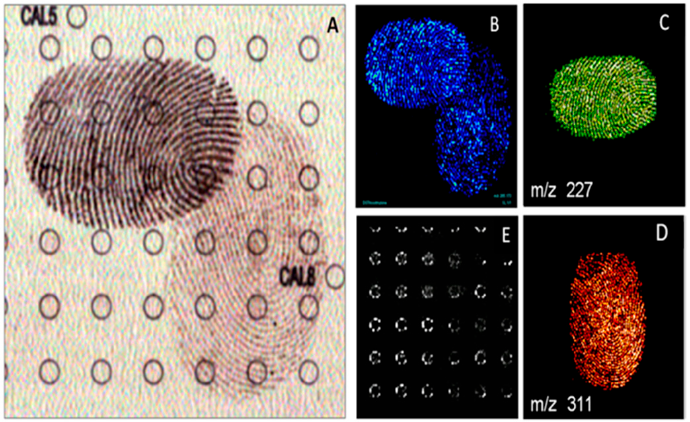
Figure 4. Optical image of fingermarks from different persons ( A ) shows several common ions (( B ) an image from an unidentified common ion) but can be fully resolved using different intensities of fatty acids. ( C ) Image of m / z 227, probable identification myristic acid; ( D ) image of m / z 312, probable identification arachidic acid; and ( E ) a background ion. Full mass spectra of fingermarks are reported in Supplementary Material S1.